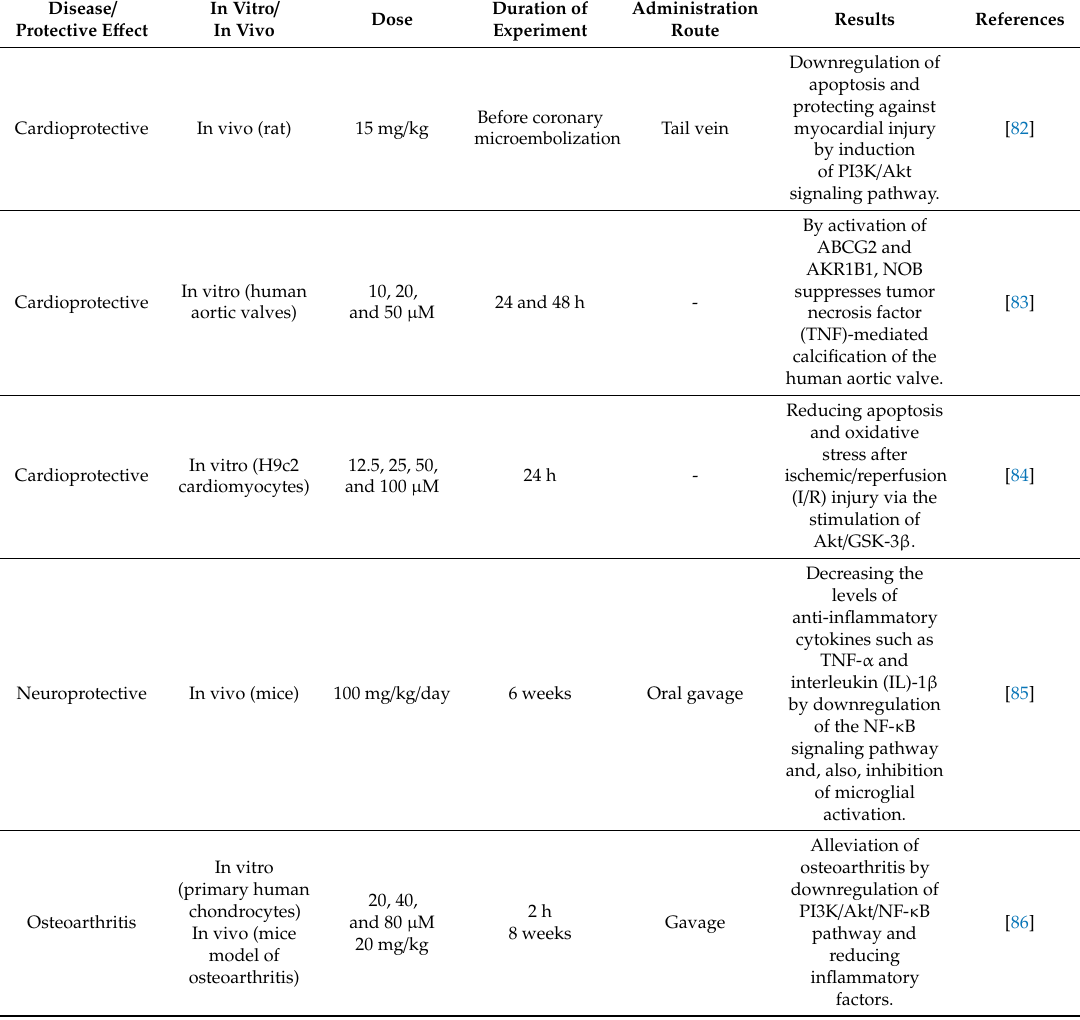
Table 1. Therapeutic and biological activities of nobiletin